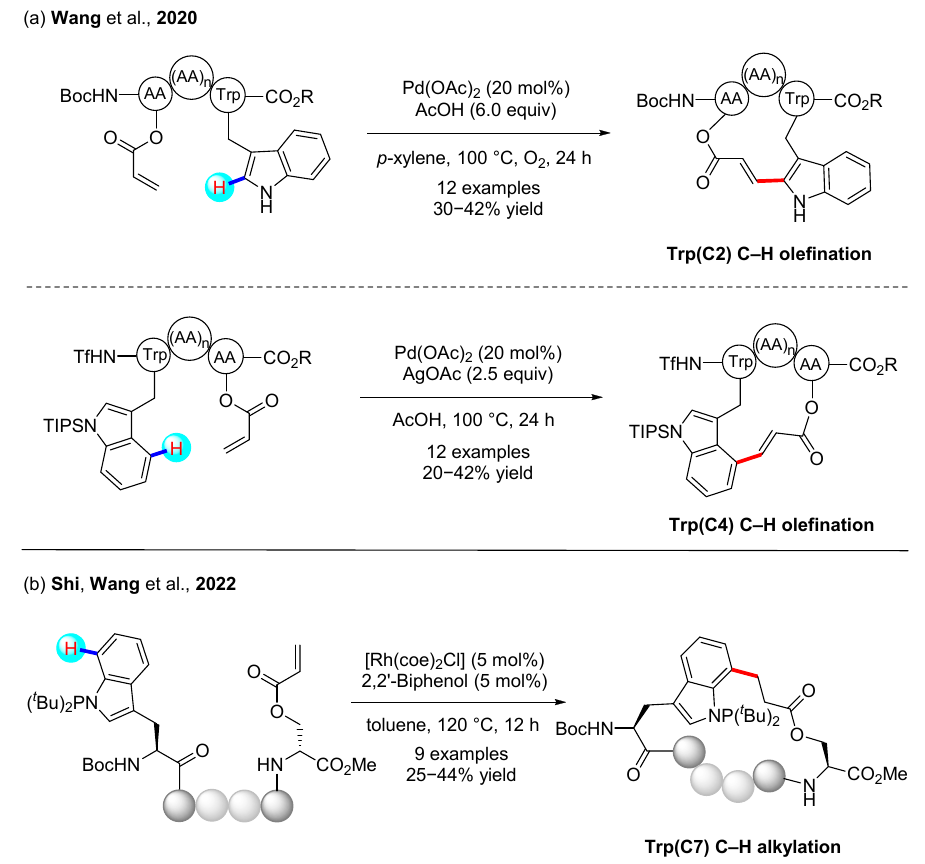
Figure 10. Peptide macrocyclizations via site ‐ selective intramolecular C(sp 2 ) − H bond functionalization of tryptophan [68,69].